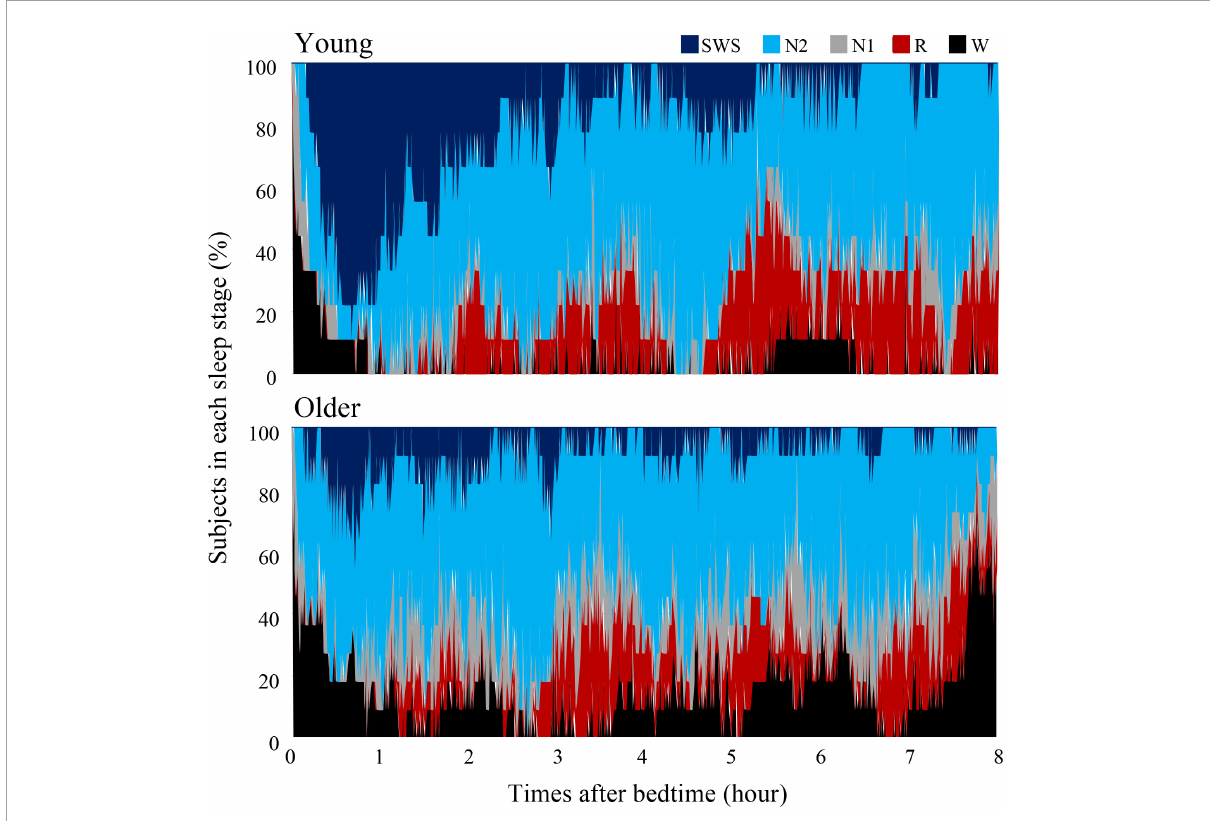
FIGURE1 Cumulative display of sleep architecture. Distribution of sleep stages of 9 subjects in the young group and 11 subjects in the older group. The percentage of subjects in each sleep stage is shown; Wake (black), REM sleep (red), NREM Stage 1 (gray), NREM Stage 2 (light blue), and NREM Stage SWS (blue). Data of young group was presented in our previous study to compare sleep architecture of follicular and luteal phase (Zhang et al.,